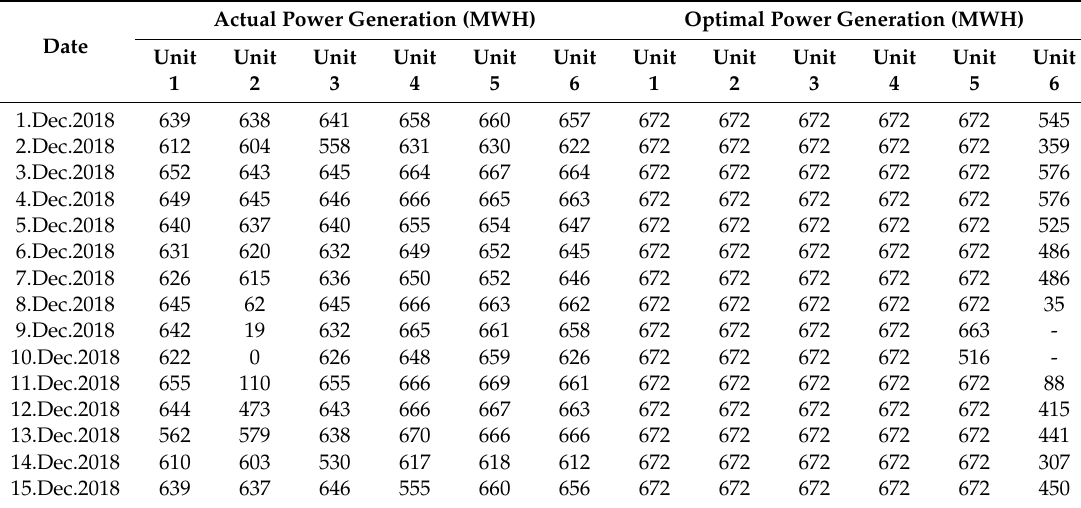
Table 5. The load distribution of units in actual and optimal